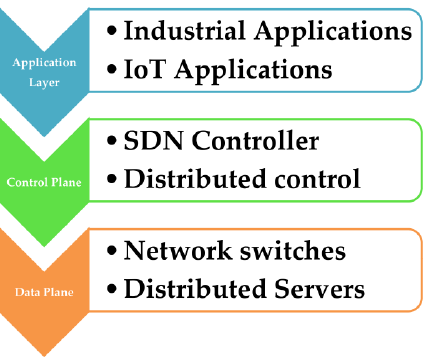
Figure 1. Basic Data flow Structure of SDN.